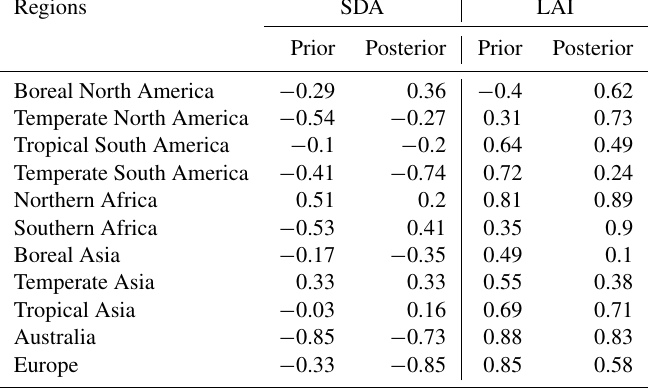
Table 5. Correlation coefficients of severe drought areas (SDAs) and the regional mean LAI with the BIO sinks in each region. Regions SDA LAI Prior Posterior Prior Posterior Boreal North America − 0.29 0.36 Temperate North America − 0.54 −